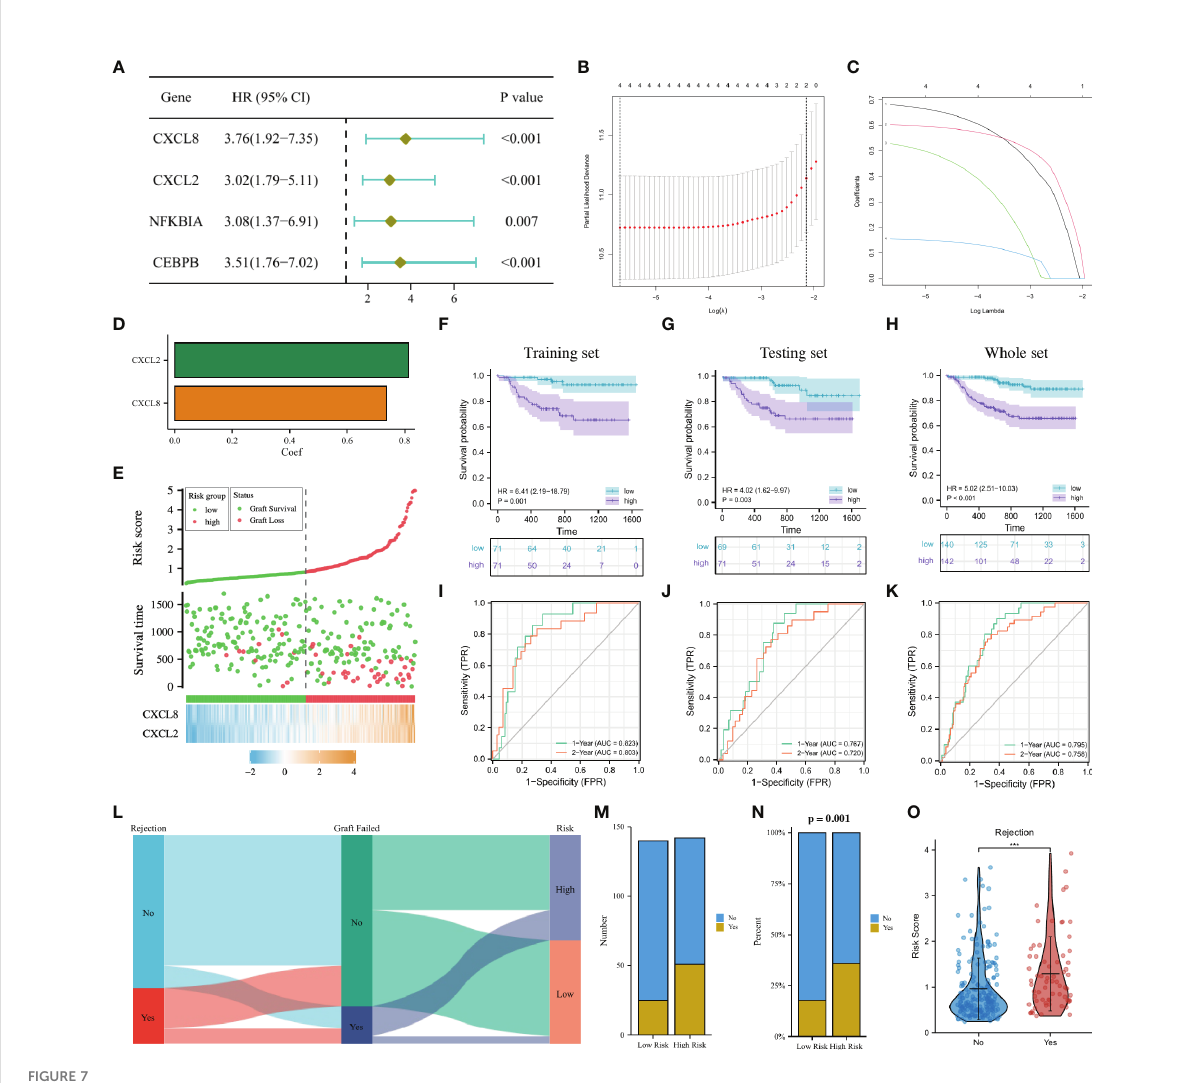
FIGURE 7 Construction of a predictive signature for the long-term survival. (A) : Forrest plot of univariable Cox regression analysis. (B, C) : The 2 candidate NRGs obtained by LASSO regression with 10-fold cross-validation. (D) : LASSO coef fi cients pro fi les of candidate NRGs in the signature. (E) : Risk map of the two risk groups. (F – H) : K-M survival analysis of the model in the training set, the testing set and the whole set. (I – K) : Time- dependent ROC analysis in the training set, the testing set and the whole set. (L) : Sankey diagram showing the relationship among the occurrence of AR, long-term graft failure and the risk of recipients. (M, N) : Histogram comparing the differences in the occurrence of AR between the two groups. (O) : Comparison of the risk score between AR and non-AR recipients. NRGs, NET-related genes; LASSO, least absolute shrinkage and selection operator; K-M, Kaplan – Meier; ROC, receiver operating characteristic; AR, acute